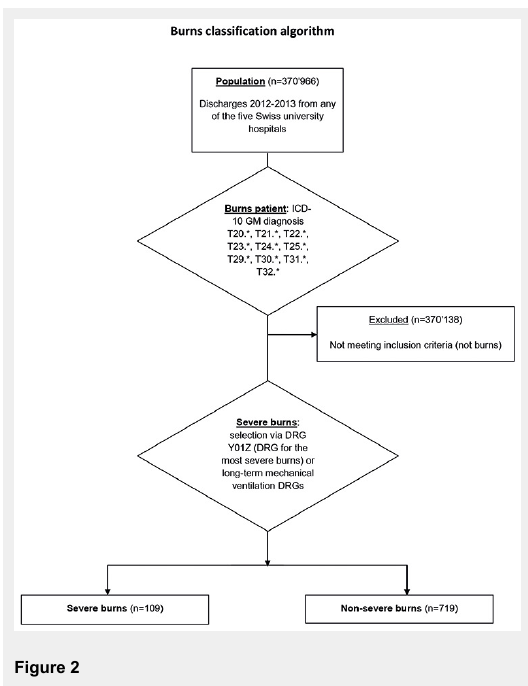
Figure 2 Burns classification algorithm. ICD10-GM = International Classification of Diseases, 10th revision, German